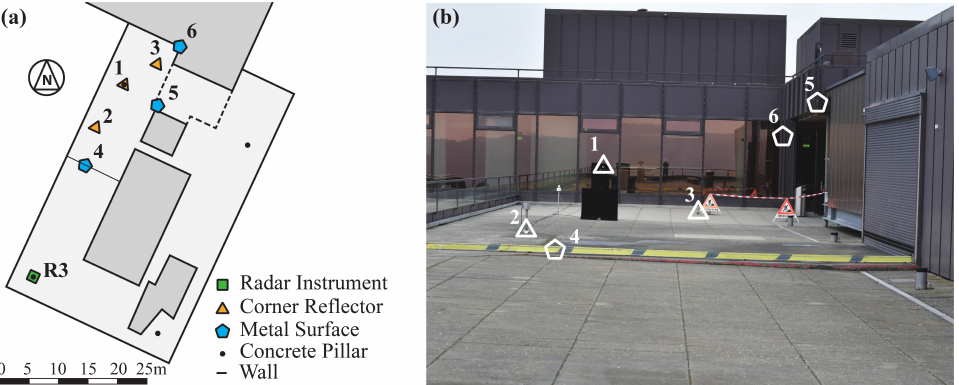
Figure 8. ( a ) Floor map of the measurement setups highlighting the positions of the radar instrument (square), the corner cubes (triangle), and other targets (pentagon). ( b ) Measurement setup for the dynamic experiment on the roof terrace.